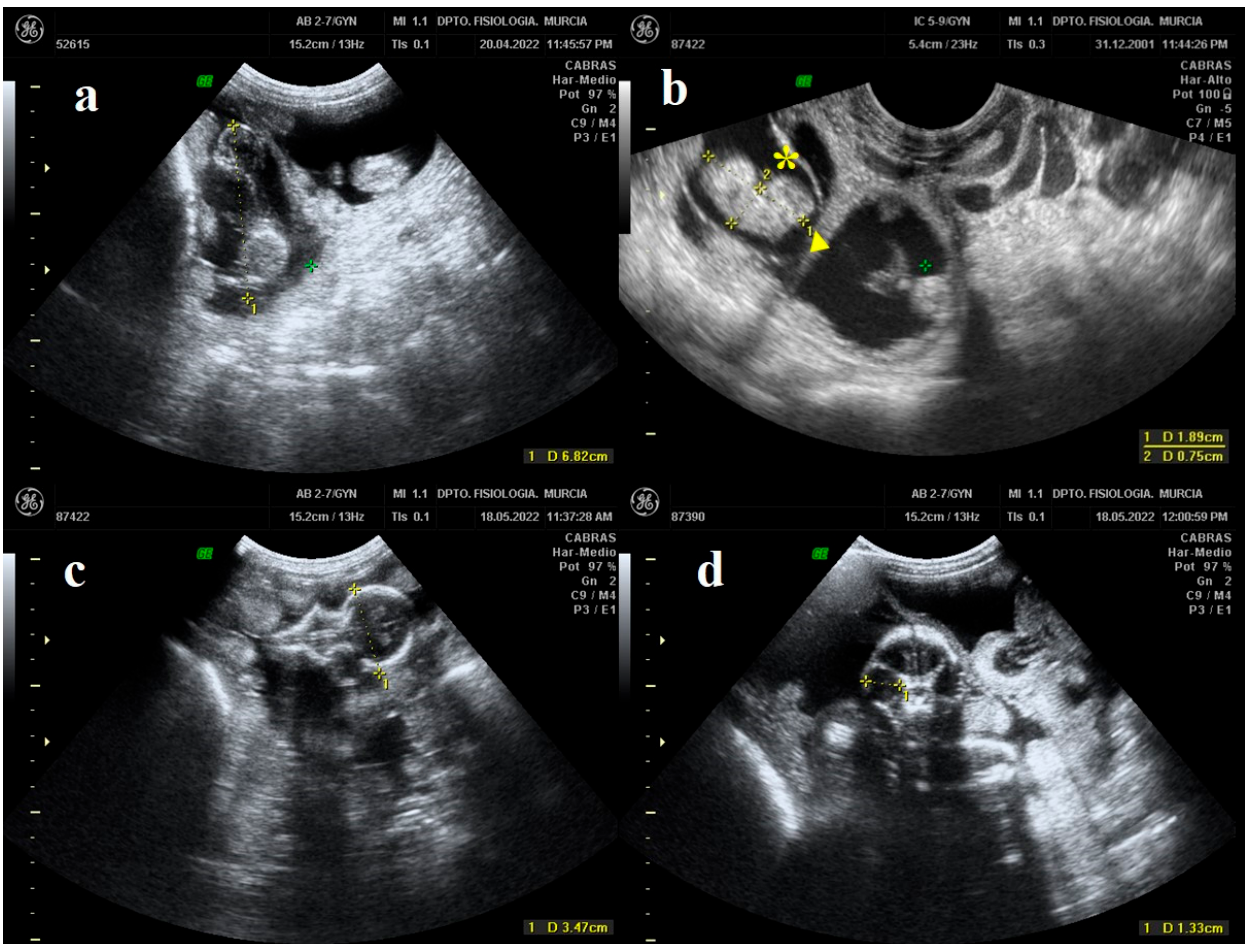
Figure 1. B-mode ultrasound images in which fetal growth indices are measured. ( a ) The yellow line represents the crown-rump length (CRL). ( b ) The yellow line marked with ( ► ) represents the crown-rump length (CRL) and the one marked with ( * ) represents the trunk diameter (TD). ( c ) The yellow line represents the biparietal diameter (BPD). ( d ) The yellow line represents the eye orbit diameter (EOD).